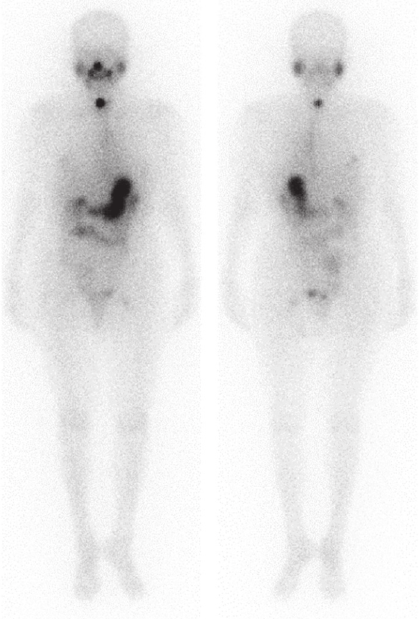
Figure 3: Iodine-131 scintigraphy after radioactive iodine therapy. No uptake was observed in the metastatic